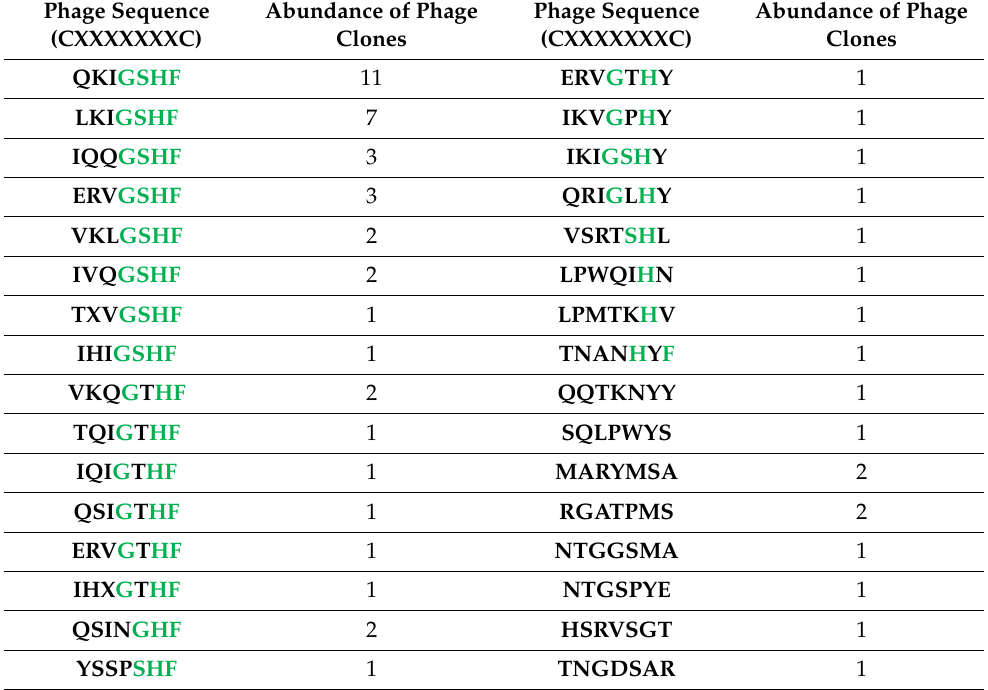
Table 1. The peptides screened from the phage display libraries after 3–4 selection rounds are shown. The library heptapeptides are loop-constrained by a pair of flanking cysteine (C) residues. The most abundant amino acids, G, S, H and F, are in green print. Phage Sequence Abundance of Phage Phage Sequence (CXXXXXXXC) Clones